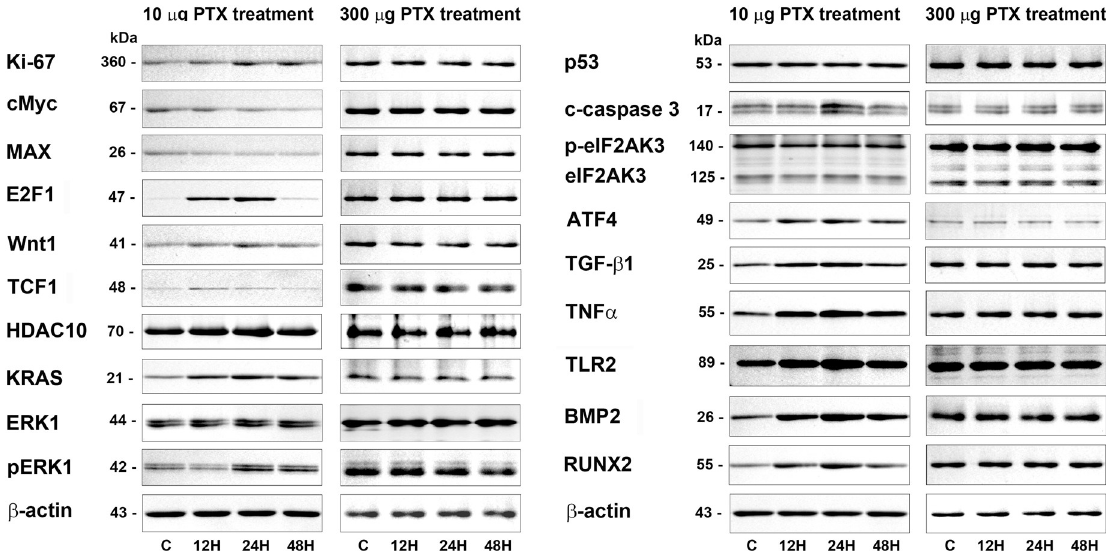
Fig 7. Western blot comparison between 10 μ g/mL and 300 μ g/mL PTX-induced protein expressions in RAW 264.7 cells regarding the proliferation (Ki-67, cMyx, MAX, E2F1, Wnt1, and TCF1), epigenetic modification (HDAC10), RAS signaling (KRAS, ERK1, and pERK1), apoptosis (p53 and c-caspase 3), ER stresses (eIF2AK3, p-eIF2AK3, and ATF4), inflammation (TNF α and TLR2), and osteogenesis (BMP2, and RUNX2). The level of β -actin expression was used as an internal control.